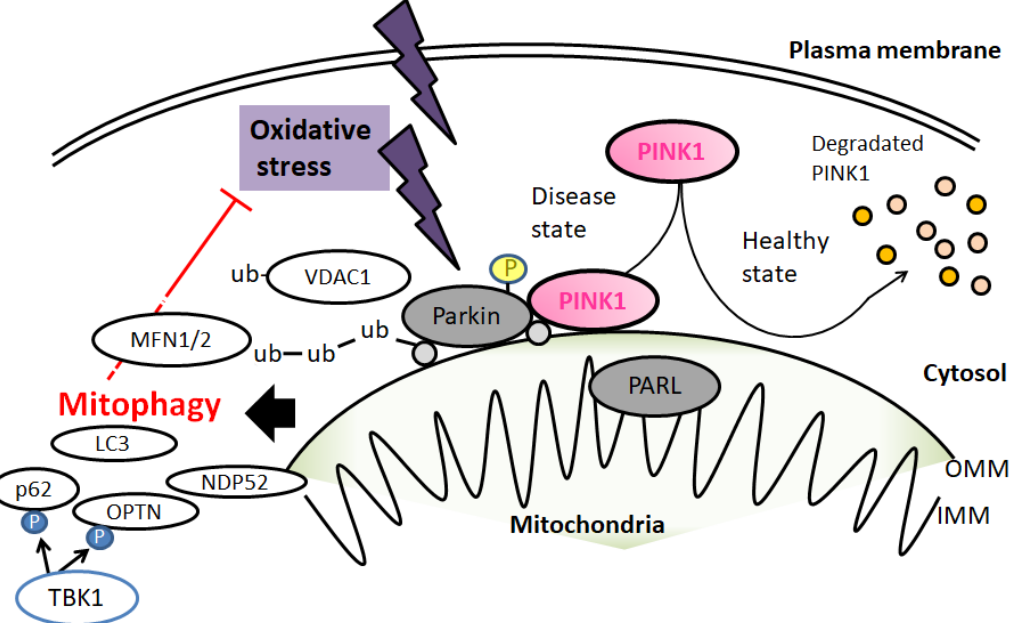
Figure 1. A hypothetical schematic representation and overview of PINK1, Parkin, and related molecules in a regulatory pathway for mitophagy. Under a healthy and steady state of cells, PINK1 is degraded within the surface of mitochondria. This may be inhibited by mitochondrial damage due to various oxidative stresses, resulting in PINK1 and Parkin accumulation in the outer membrane of mitochondria (OMM). Then, PINK1 phosphorylates ubiquitin to activate Parkin ubiquitin ligase activity. In addition, Parkin is also assumed to be phosphorylated and ubiquitinated, resulting in the induction of mitophagy. Note that some critical pathways have been omitted for clarity. OMM: outer mitochondrial membrane; IMM: inner mitochondrial membrane.